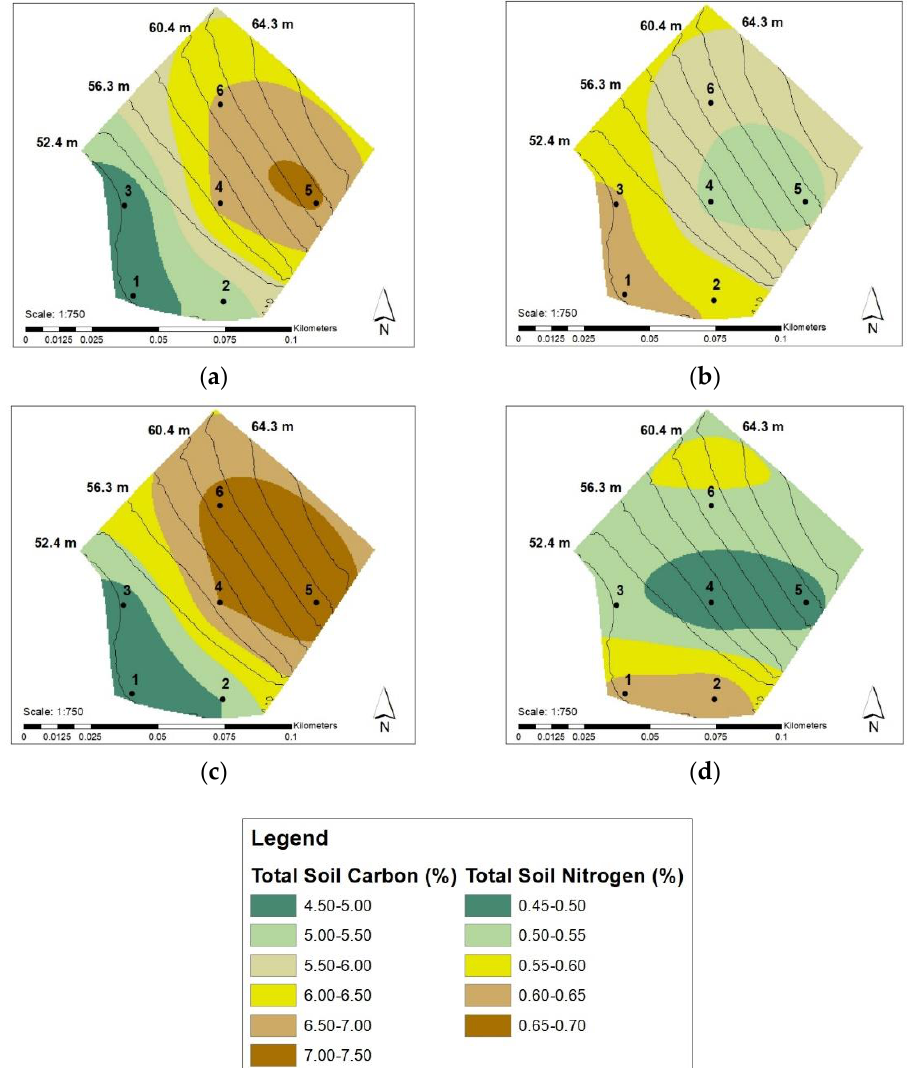
Figure 3. Interpolated total soil C (%) and total soil N (%) content for ( a ) C in 2020; ( b ) C in 2021; ( c ) N in 2020 and ( d ) N in 2021. Included are gridded soil sampling points and 2-metre contour intervals. As a result of tillage and reseeding, this site has had overall mass wasting of 324.37 Table 1. Average Soil Nutrient Content (mg L −1 ) for P, Mg, K, and S, Total Soil C (%) and Total Soil N (%) of corresponding 35 m gridded soil sampling points for identified deposition and erosion zones.